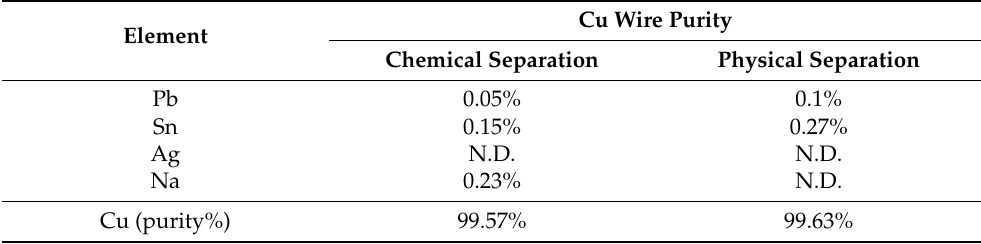
Table 3. The component of copper wire after two coating layers removing methods.